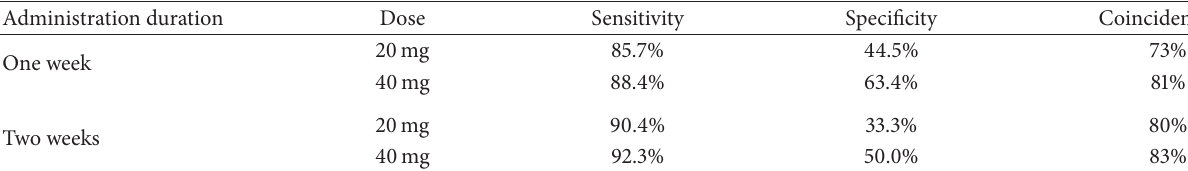
Table 5: Comparison of rabeprazole tests of different doses and treatment courses.